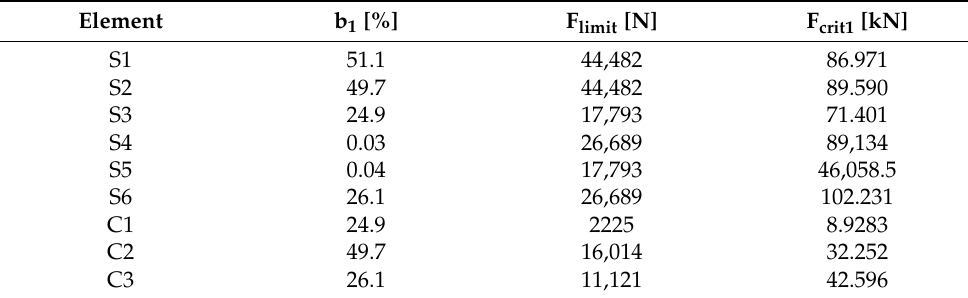
Figure 17. The highlighted position of the evaluated elements. Table 3. Recalculation of critical force for test case